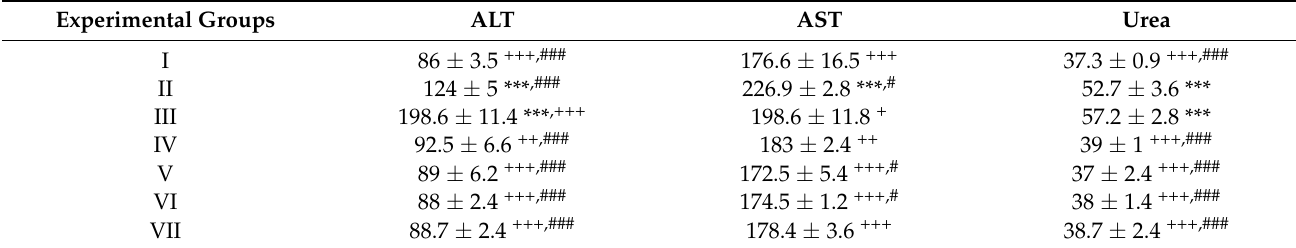
Table 2. Serum biochemical parameters (ALT, AST and urea) in experimental groups. Experimental Groups